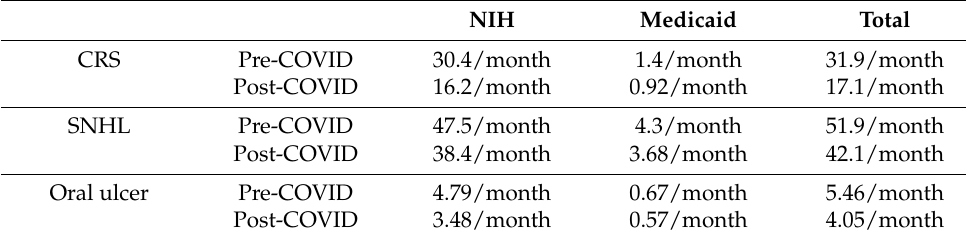
Table 1. Number of 1st visit patients per month during peri-pandemic era.